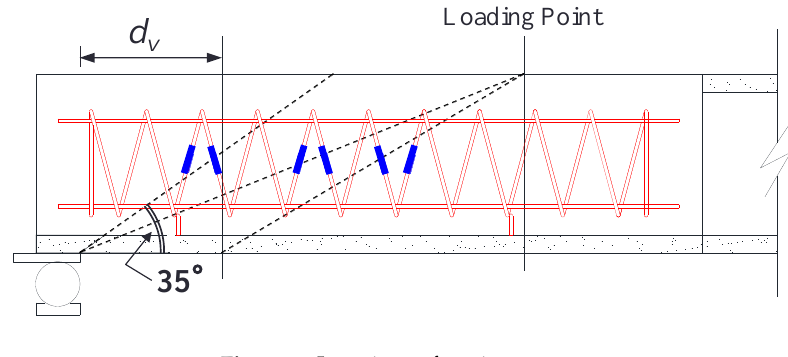
Figure 5. Locations of strain gauges.